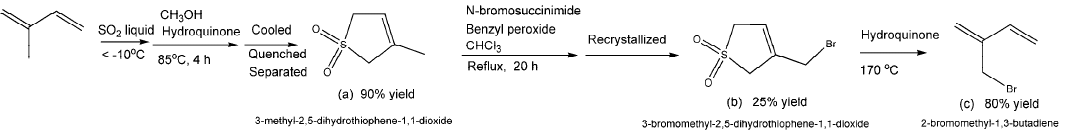
Figure 13. Synthesis of 2-bromomethyl-1,3-butadiene [144].